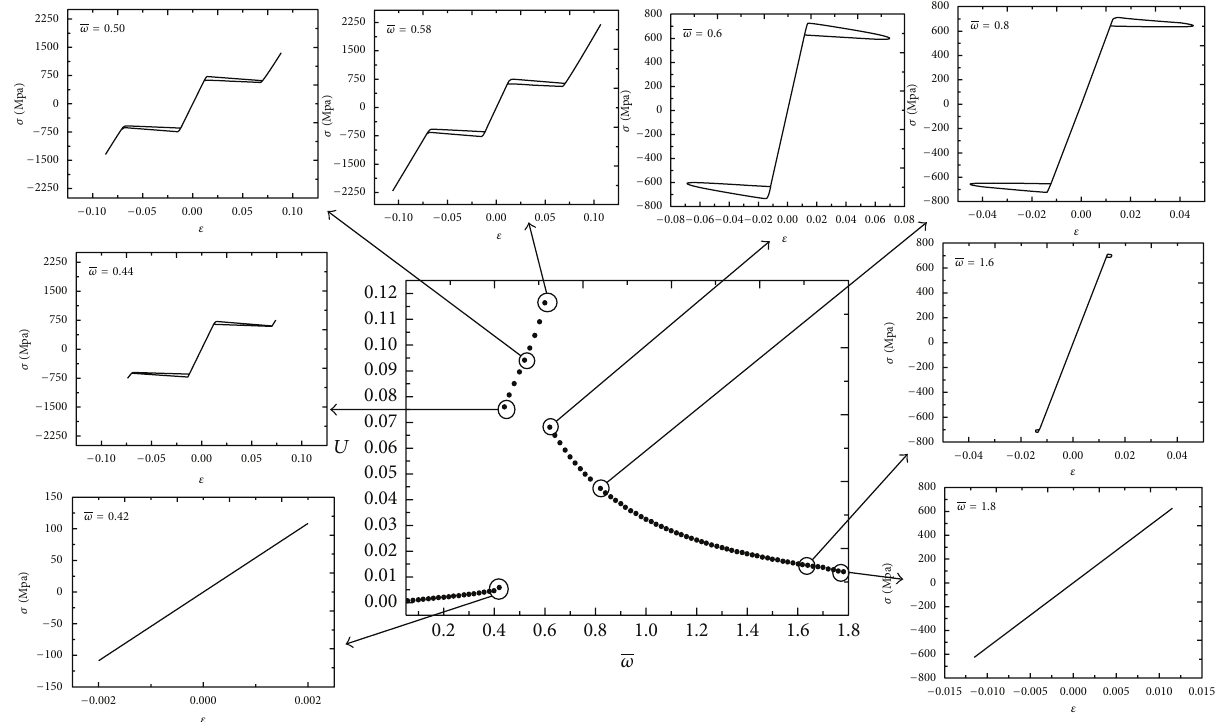
Figure 4: Down-sweep jumps with V = 0.025 m/s: comparison between frequency response and stress-strain